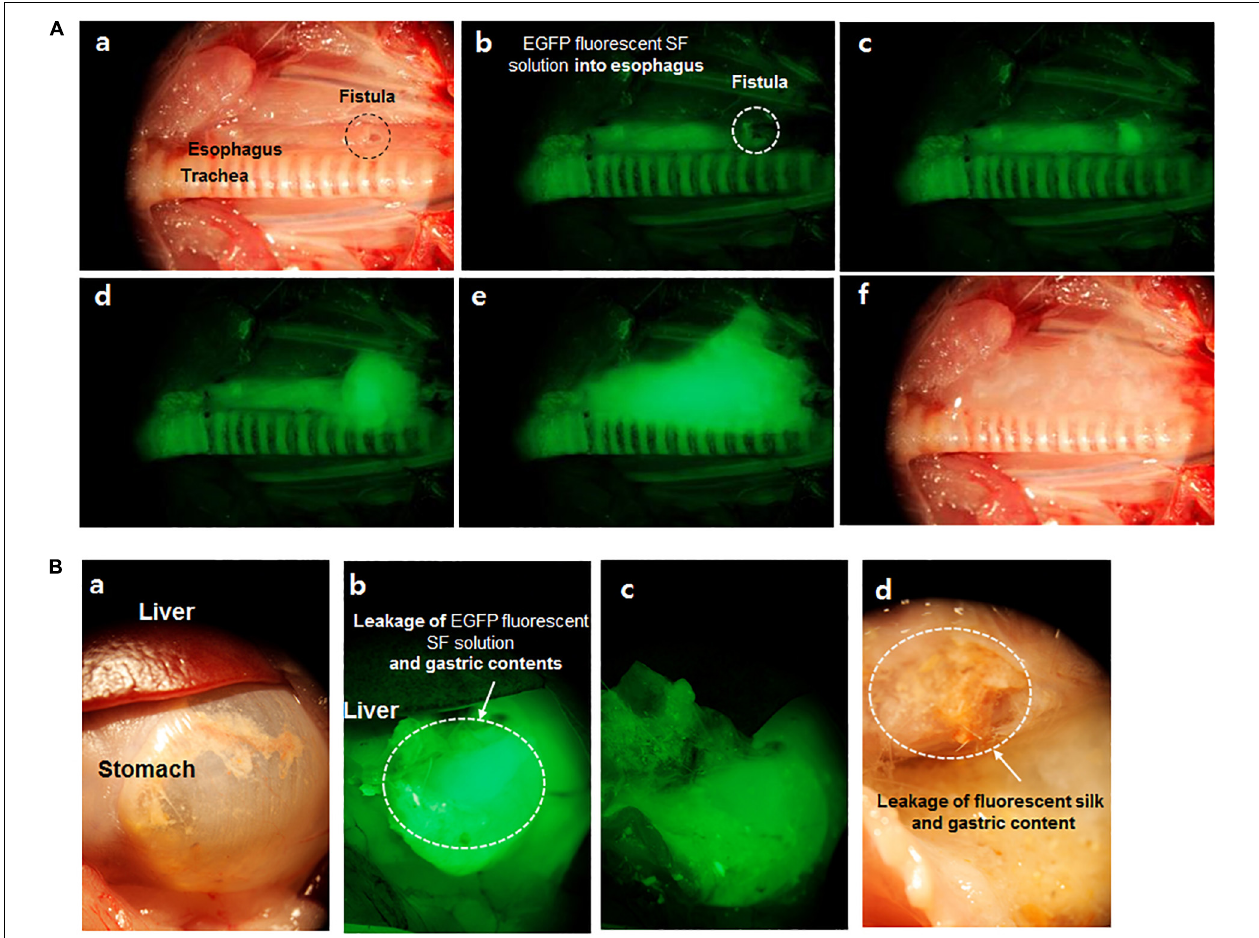
FIGURE 6 | Images of EGFP fluorescent SF solution in esophageal (A) and stomach (B) fistula of the rat. (a) Esophageal fistula (0.5 mm) image with white light reflectance, (b–e) EGFP fluorescent captured images per 0.3 s. EGFP fluorescent was detected at esophageal fistula according to time passed under fluorescent light, (f) Image of leaked EGFP fluorescent SF from fistula with white light reflectance. (B ,a ) Stomach and liver image with white light reflectance light (b,c) Leakage image of EGFP fluorescent SF solution and gastric contents from fistula site after feeding of EGFP fluorescent SF solution under fluorescent light, (d) Leakage image of EGFP fluorescent SF solution and gastric contents with white light reflectance light. Reproduced from Kim et al. (2015) with permission from